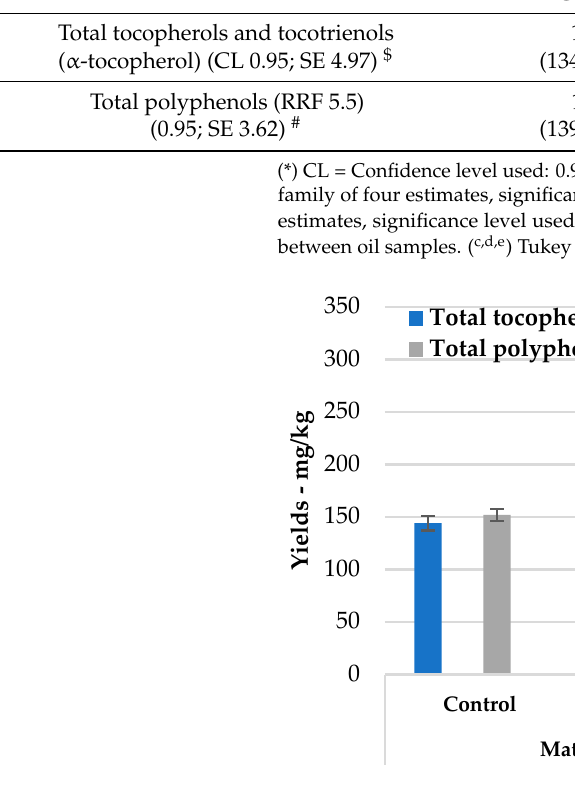
Table A1. Energy consumption: Control vs. US-assisted extractive process on Taggiasca olives. Mature Green Parameters Control US a Control US a Process flow rate (kg/h) ~400 Oil yield ( w / w %) Total Energy Consumption/hour (kW/h)